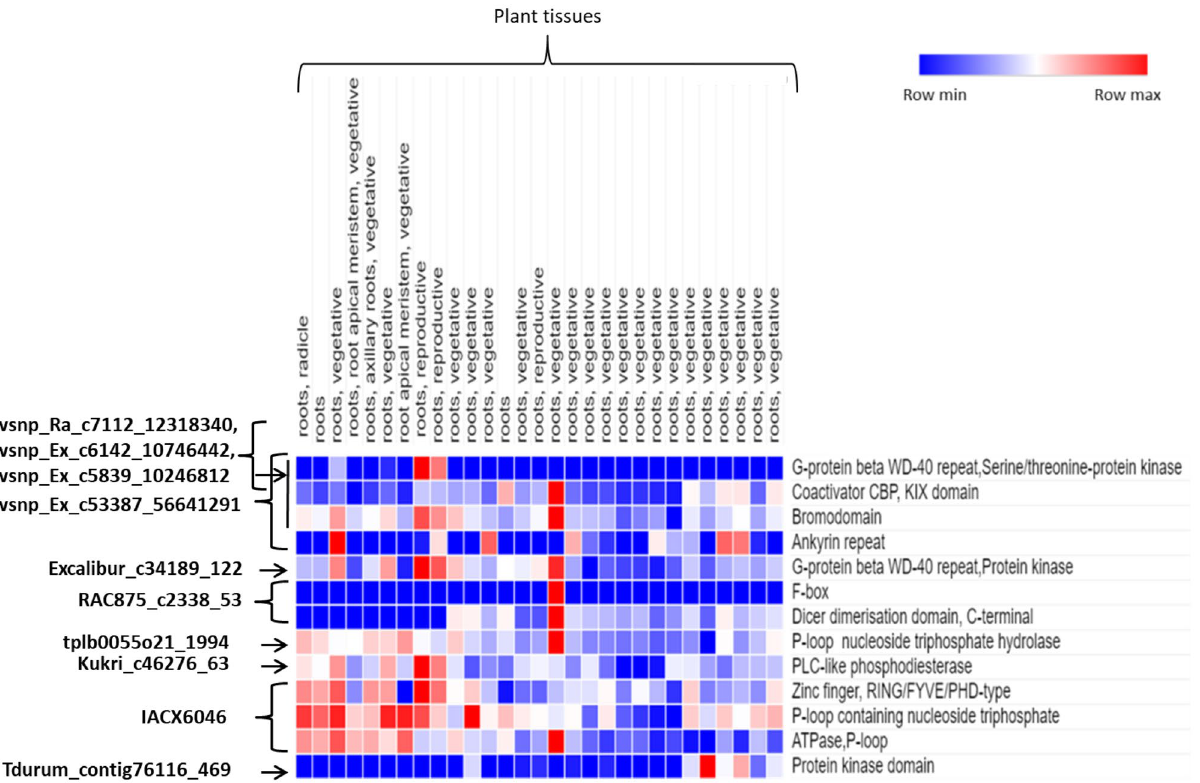
Figure 7. Expression profiles of candidate genes obtained in 180 wheat accessions under CE (combined environment) in wheat roots. Blue, white and red indicate low, medium, and high expression,